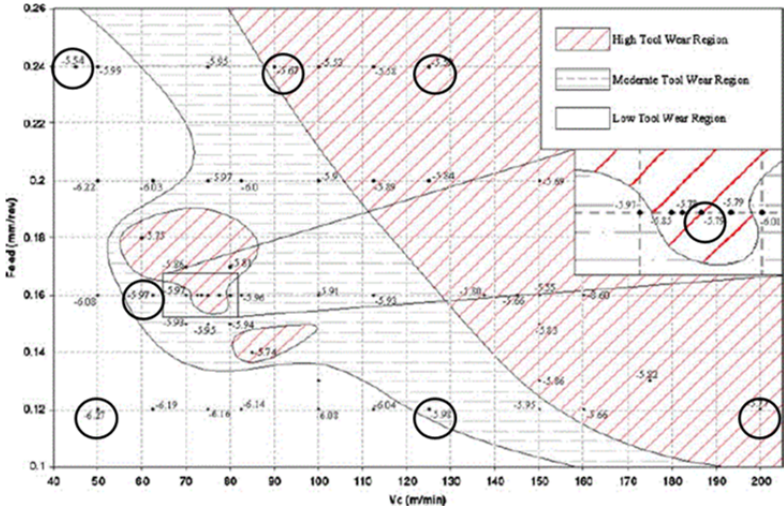
Figure 3. Wear map adopted from Jaffery and Mativenga (2009) with cutting conditions for study highlighted.